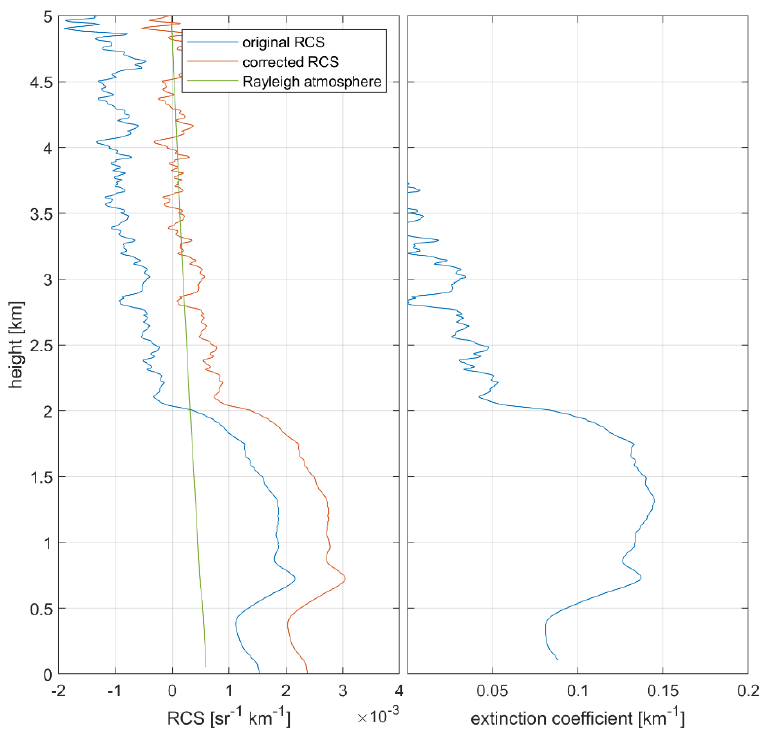
Figure 2. Left : Original ceilometer RCS profile (blue) at 21:20, 14 June, an average of 30 min measurements. The profile was vertically smoothed by a moving average filter of 100 m. This profile was further corrected by the dark measurement, factor C, and cosmetic shift FCS, and the corrected profile is the orange curve. The green line demonstrates the Rayleigh atmosphere. Right : Particle extinction coefficient derived from ceilometer observations, with a calculated AOD of 0.269, which agrees with sun-photometer measurement. The detailed calculation can be found in Section S8 of Supplementary Materials.